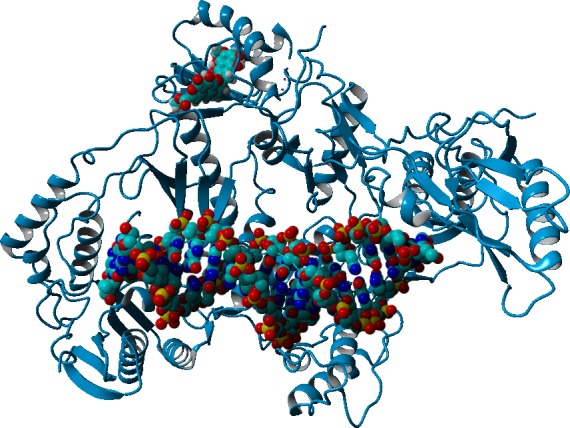
Preferential binding mode of ligand 28 to HIV reverse transcriptase, as computed with AutoDock, with superposed DNA molecule taken from the DNA-bound HIV structure (PDB: 2HMI) (Ding et al., 1998).